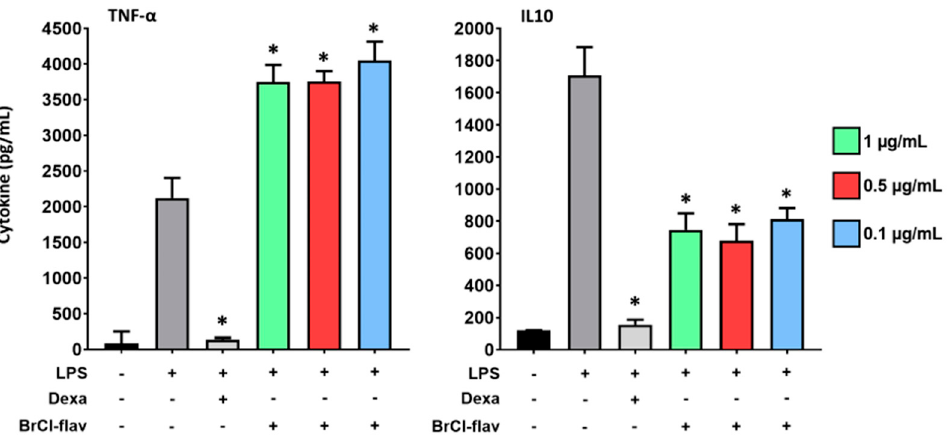
Figure 10. Effect of BrCl-flav on LPS-induced secretion of tumor necrosis factor-alpha (TNF- α ) and interleukin 10 (IL10) in U937-macrophages. U937 cells were differentiated into macrophages by incubation in the presence of 25 nM-PMA for 48 h, and then after 3 days of PMA weaning, cells were seeded in 12-well plates at the density of 2 × 10 6 viable cells/well. Cytokine production was measured after 4 h of incubation with culture medium (black), LPS at 50 µ g/mL (dark grey), or with a positive inflammation inhibition control (LPS at 50 µ g/mL + dexamethasone, 20 µ M; light grey) or with LPS (50 µ g/mL) + different concentrations of BrCl-flav (n = 4). Statistical analysis of the data was performed using Mann–Whitney tests to compare the LPS control to the dexamethasone control and samples with GraphPad Prism software (* = p < 0.05). Results are presented as bar graphs (means and standard deviations).